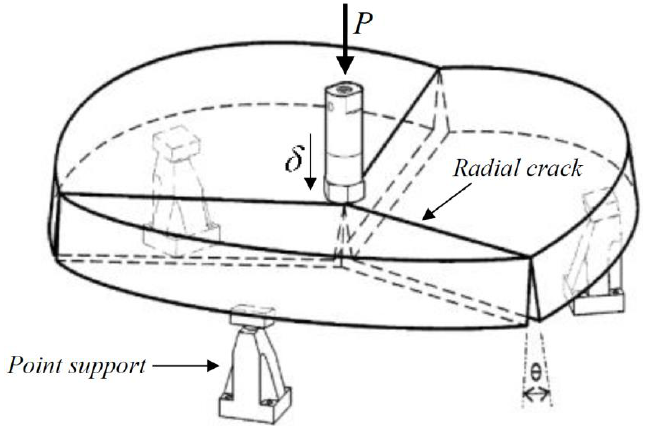
Figure 15. RPT-3ps setup with three-point support and normal failure mode ( P and δ represent, respectively, the central load and deflection) [42].